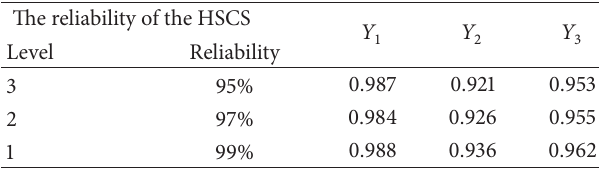
Table 4: The reliability of the HSCS levels affecting 𝑌 1 , 𝑌 2 , and 𝑌 3 . The reliability of the HSCS